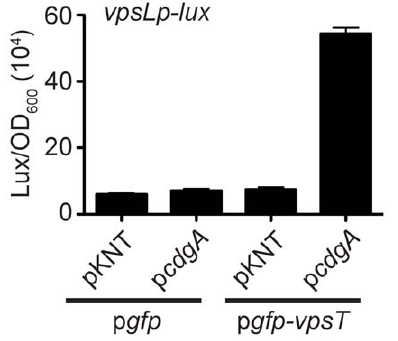
Figure 5. Co-expression of VpsT and CdgA Activates vpsL Expression in E.coli. Expression of the vpsL promoter fused to a lux reporter operon in E. coli expressing GFP or GFP-VpsT and harboring pKNT vector alone or pKNT containing cdgA . Expression is reported in luminescence counts min 2 1 ml 2 1 /OD 600 nm . One representative exper- iment of three biological replicates is shown. Error bars indicate standard deviations of four technical replicates.